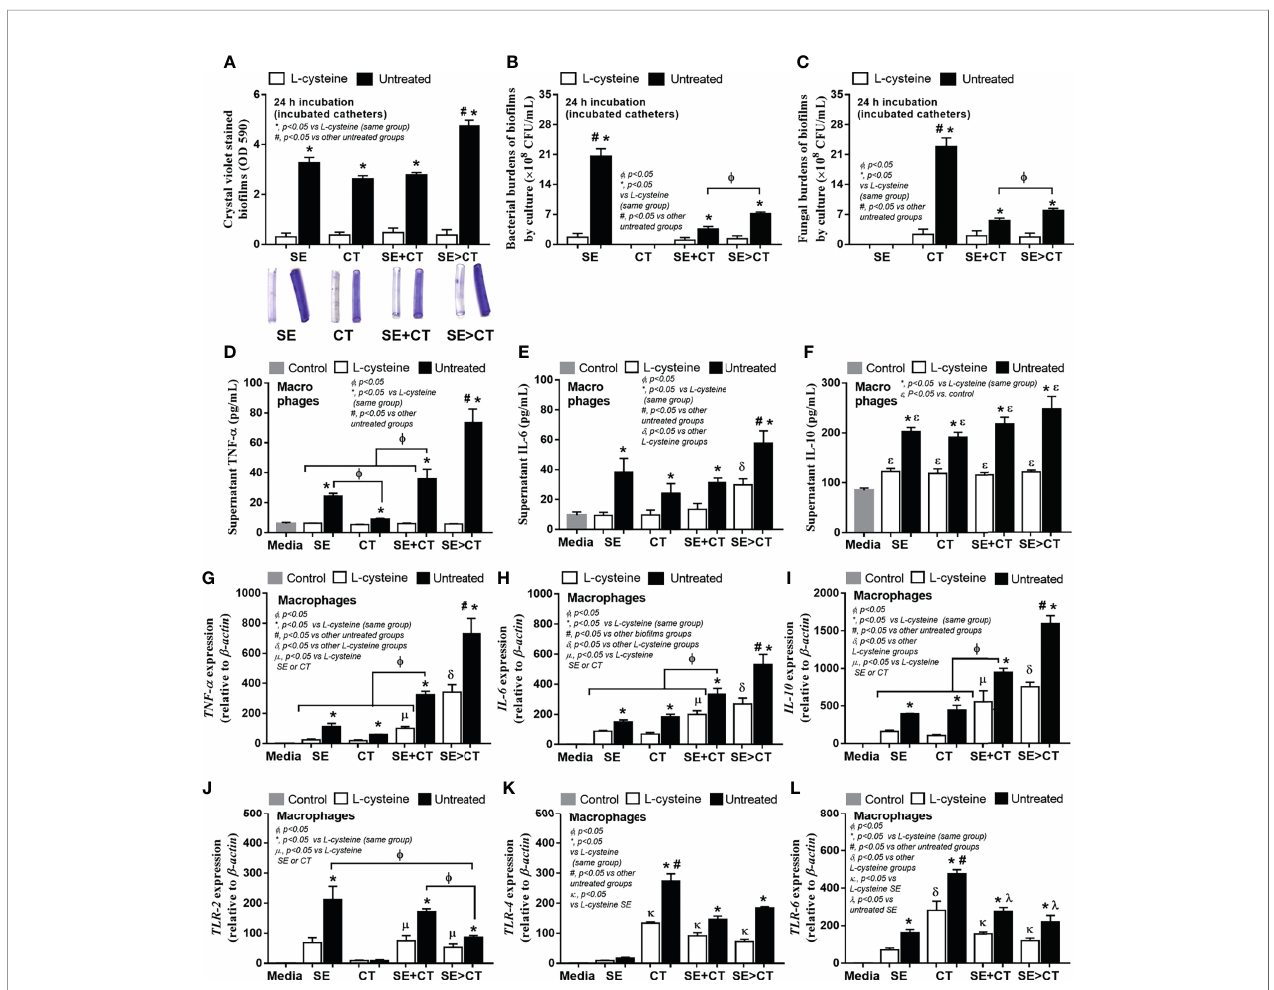
FIGURE 5 | Characteristics of catheter bio fi lms from clinically isolated Staphylococcus epidermidis (SE), Candida tropicalis (CT), SE simultaneously mixed with CT (SE + CT), and preformed SE bio fi lms following by CT (SE > CT) with L -cysteine (50 mM) as determined by crystal violet intensity (A) ; and microbial burdens (bacteria and fungi) by culture from the bio fi lms (B, C) are demonstrated (independent triplicate experiments were performed). The responses of macrophages against bio fi lms from different groups as determined by cytokines (TNF- a , IL-6, and IL-10) in supernatant (D – F) with expressed genes for cytokines ( TNF- a , IL-6 , and IL-10 ) (D – I) and in fl ammatory receptors ( TLR-2 , TLR-4 , and TLR-6 ) (J – L) are demonstrated (independent triplicate experiments were performed). Notably, the control groups (Control) were macrophages incubated with only culture media, while all gene expressions were calculated relative to the control